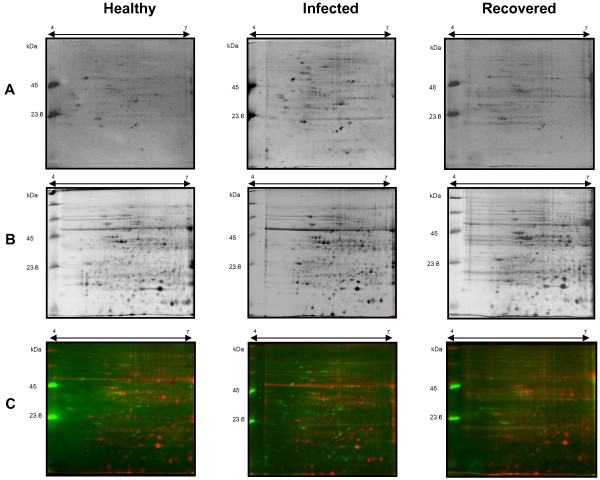
2-DE proteomic maps of proteins and phosphoproteins of Vitis vinifera leaves from healthy, infected and recovered plants. Protein extracts were separated on 7 cm long IPG strips with a pH gradient from 4 to 7, followed by SDS-PAGE on 12% polyacrilamide gels. Panel A: ProQ Diamond staining for phosphorylated protein detection. Panel B: Sypro® Ruby staining for total protein detection. Panel C: overlap of the two images (in red Sypro® Ruby, in green ProQ Diamond).